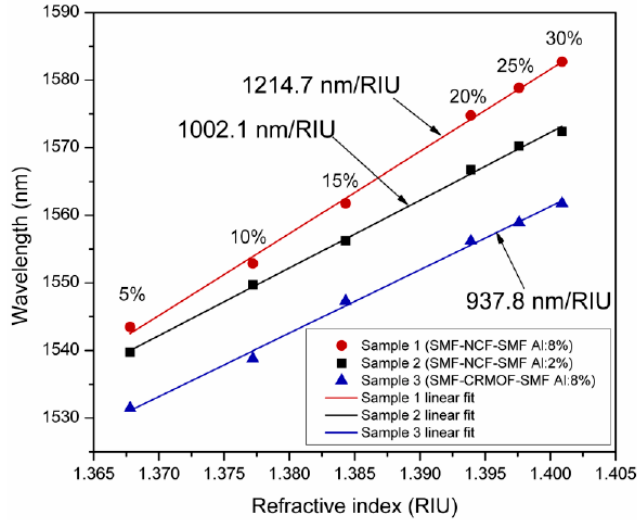
Figure 12. Variation of resonance wavelength with different concentrations of isopropyl alco- hol/glycerine, for the proposed fiber structure. Reprinted with permission from [118].